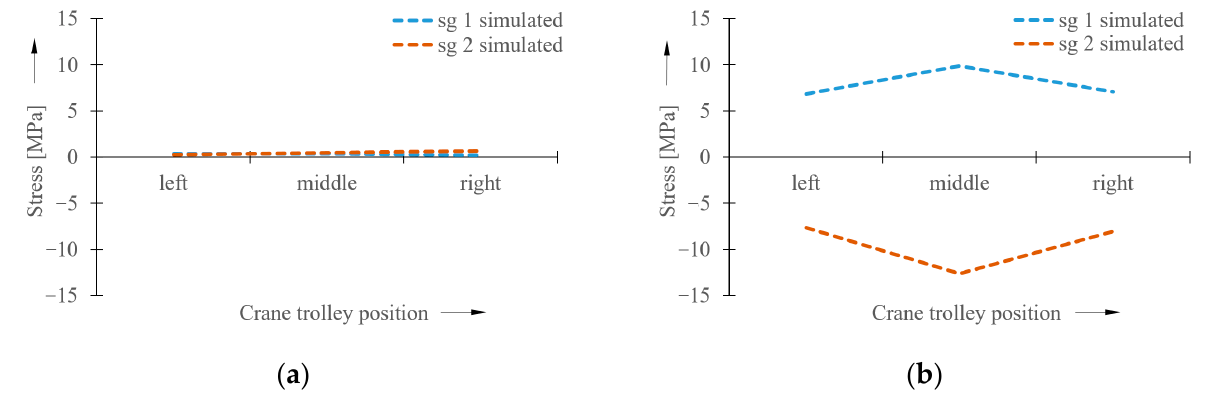
Figure 6. Stress values obtained from simulation models. ( a ) without crane skewing, ( b ) with forced crane skewing.